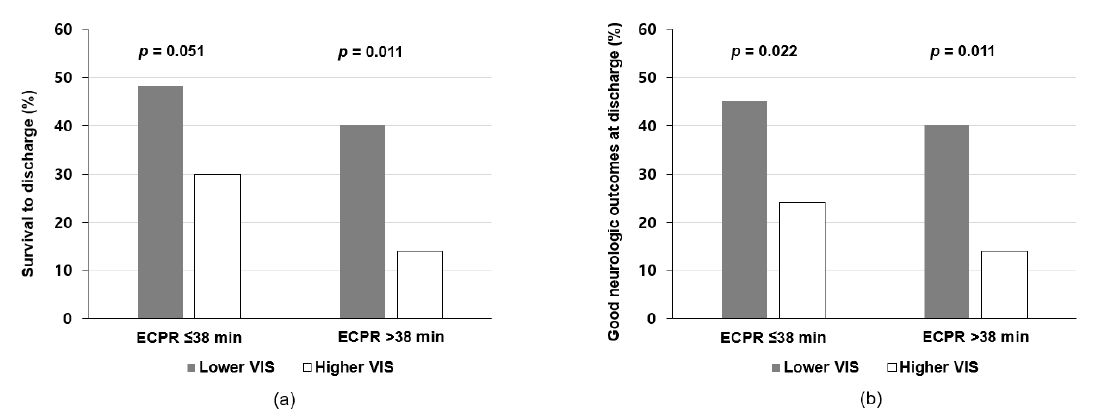
Figure 3. Subgroup analysis of the association between clinical outcomes and VIS or ECPR time. Bar plots show the results of subgroup analysis of the association between clinical outcomes and ECPR time or VIS. ( a ) Survival to discharge, ( b ) Good neurologic outcomes at discharge. ECPR = extracorporeal cardiopulmonary resuscitation, VIS = vasoactive inotropic score.